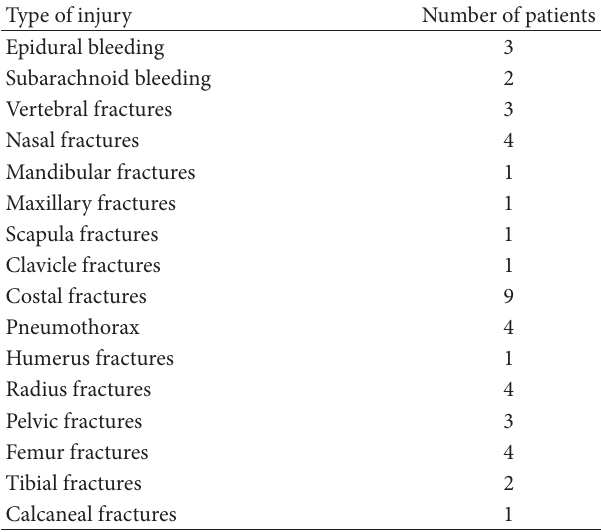
Table 3: Injuries of the trauma